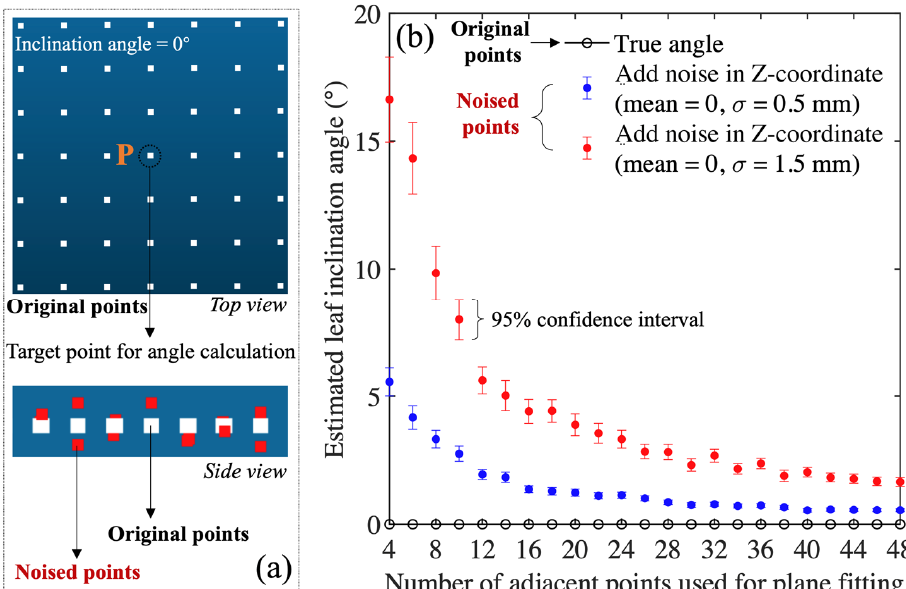
Figure 8. Influence of the noise on the inclination angle calculation. ( a ) Schematic diagram of original points (white) with a point spacing of 5 mm on a horizontal plane, and noised points (red) acquired by adding random values on Z coordinates of the original points; ( b ) influences of different levels of noise (by adding random values with a mean of zero and a standard deviation ( σ ) of 0.5 mm and 1.5 mm) on the inclination angle calculation of point P using a least squares fitting technique. P is originally on a plane with an inclination angle of 0 ◦ ; the estimated inclination angles of P on the fitted planes with different number of adjacent points increases with the noise level, and the error generally decreases with the increasing number of adjacent points when the noise level is fixed. A total of 100 datasets of the noised points for each noise level (with the same mean and standard deviation) were generated, and each angle shown in ( b ) is the average angle calculated from the 100